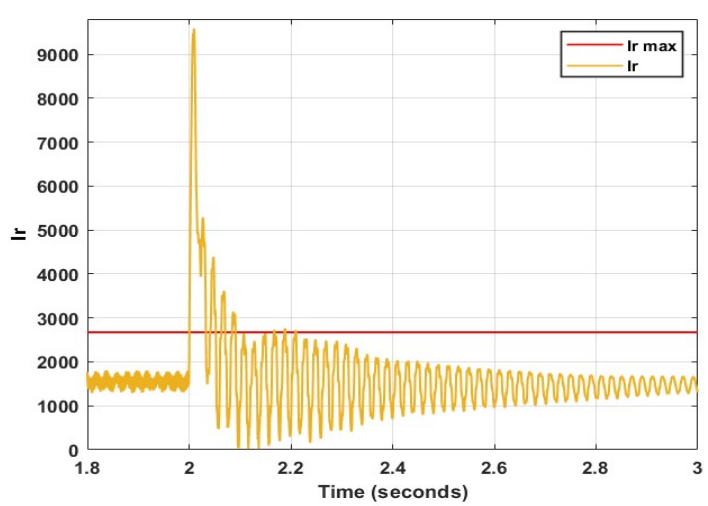
Figure 19. Rotor current transient using AVOA at 90% dip.